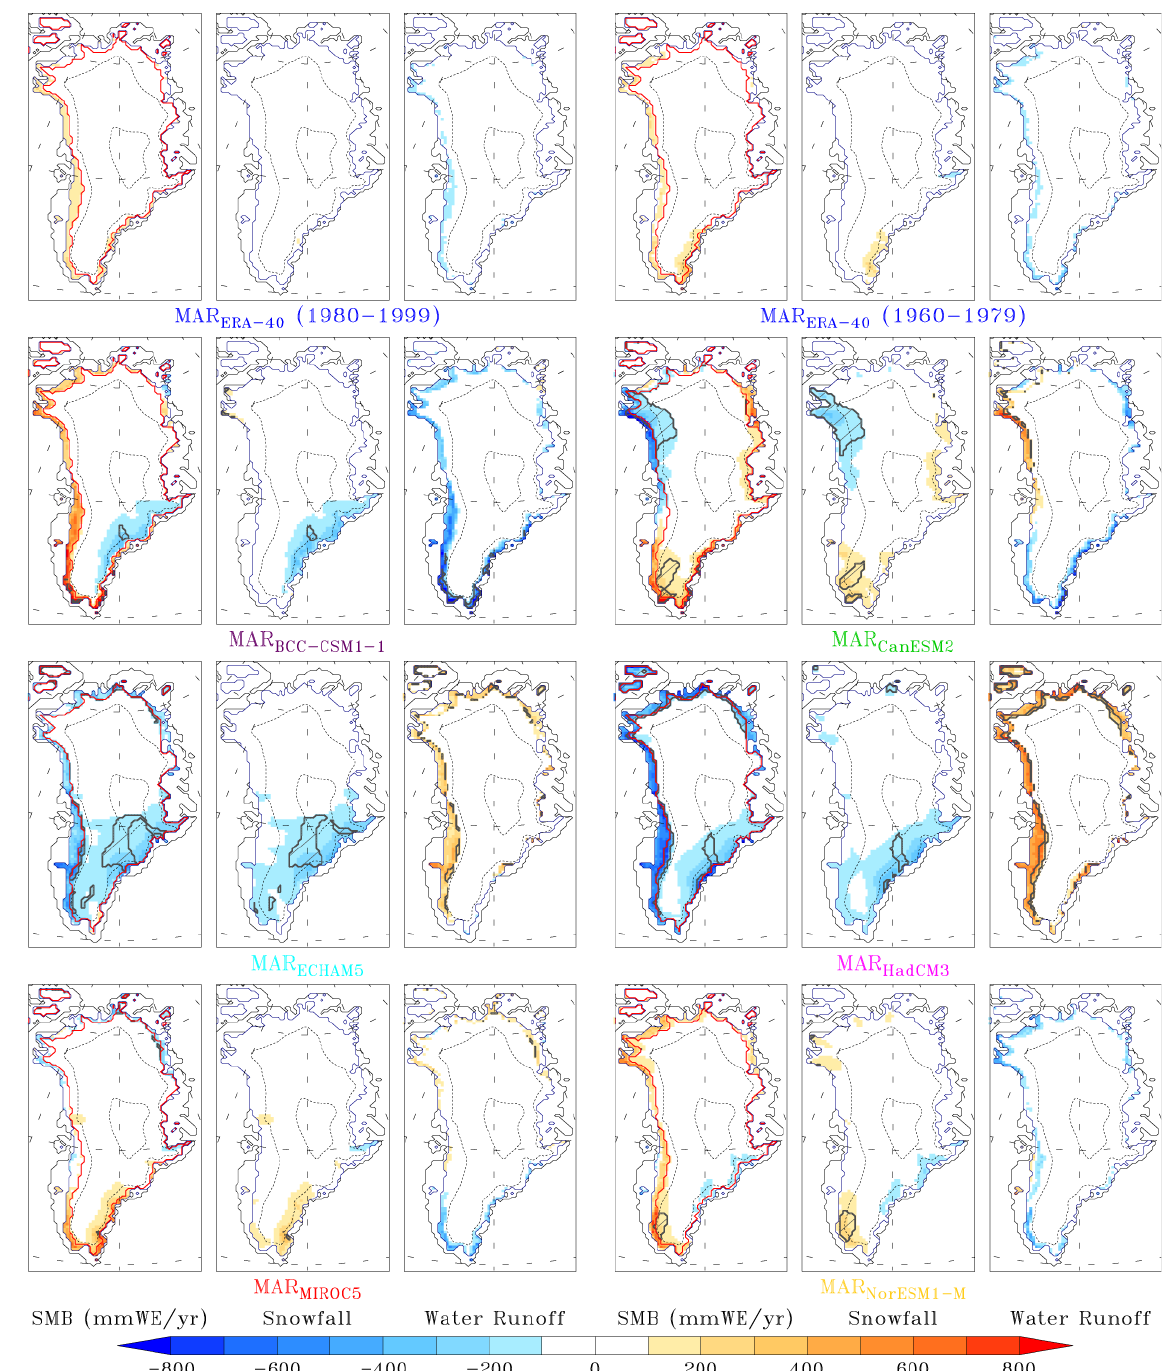
Fig. 1. Mean anomalies of the annual SMB, snowfall and water run-off with respect to the ERA-Interim forced MAR simulation over 1980–1999 for the MAR simulations listed in Table 2. The same comparison with respect to MAR ERA − 40 over 1970–1999 is available in the Supplement as Fig. S4. Units are mmWEyr − 1 . The areas where the anomalies are two times above the 1980–1999 standard deviation of MAR ERA − Interim are hatched in dark grey. The ELA from MAR ERA − Interim is plotted in red. Finally, the MAR simulations using the ICE2SEA forcings (HadCM3 and ECHAM5) are compared here with MAR ERA − Interim using the same set-up. This explains why the ice sheet mask here is a bit different in respect to the CMIP5 forced MAR